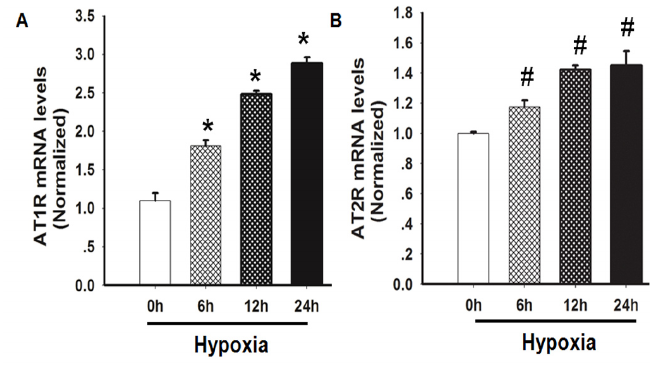
Figure 3. The effects of hypoxia on the AT1R and AT2R mRNA expression levels in HLF-1 cells. HLF-1 cells were treated with hypoxic conditions for up to 24 h. ( A ) AT1R mRNA expression was measured using RT-PCR. The data are presented as means ± SD ( n = 3). * p < 0.05 vs. 0 h following hypoxia exposure; and ( B ) The AT2R